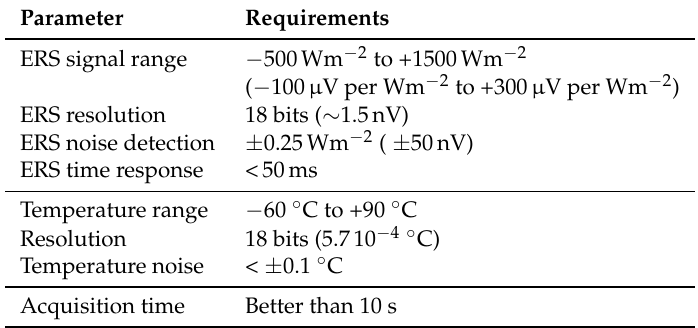
Table 4. ERS technical requirements. For all sensors, it is necessary to monitor the Temperature ( T ) with a high accuracy to take into account the temperature radiation lost (Stefan–Boltzmann law).